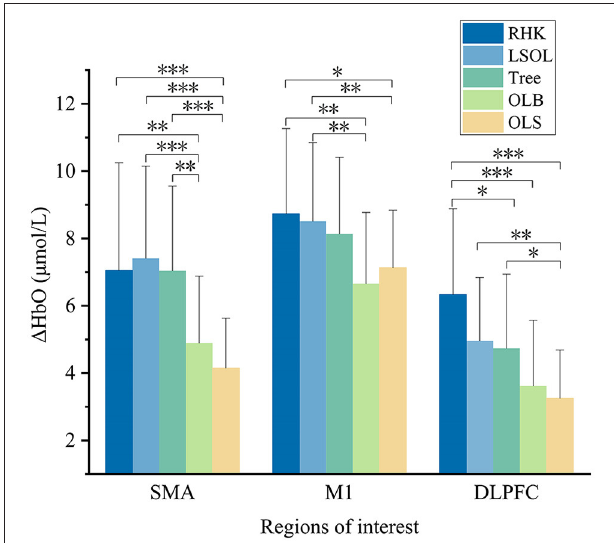
FIGURE 5 | The significant differences of cortical activation between postures. RHK, right heel kick; LSOL, left lower body and stand on one leg; OLB, one-leg balance; OLS, normal one-leg standing; SMA, supplementary motor area; M1, primary motor cortex; DLPFC, dorsolateral prefrontal cortex; Significant differences between postures: * p < 0.05, ** p < 0.01, and *** p < 0.001.